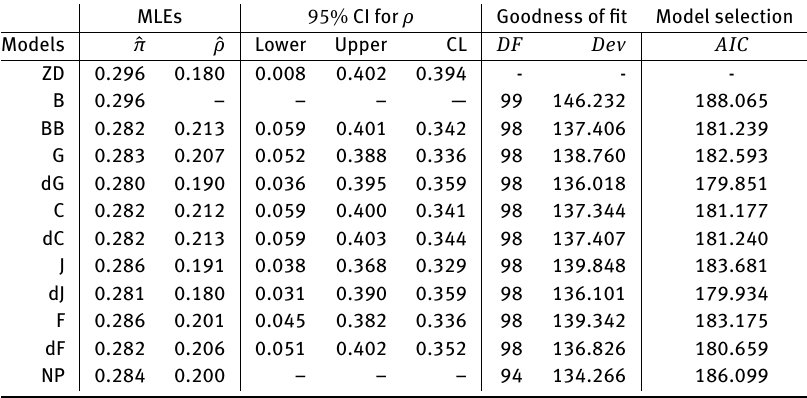
Table 8: MLEs of π and ρ , and two-sided 95% confidence interval for ρ under 11 models for the (COPD) data. Degrees of freedom ( DF ), Deviance ( Dev ) and , AIC criterion of models are also reported. MLEs 95% CI for ρ